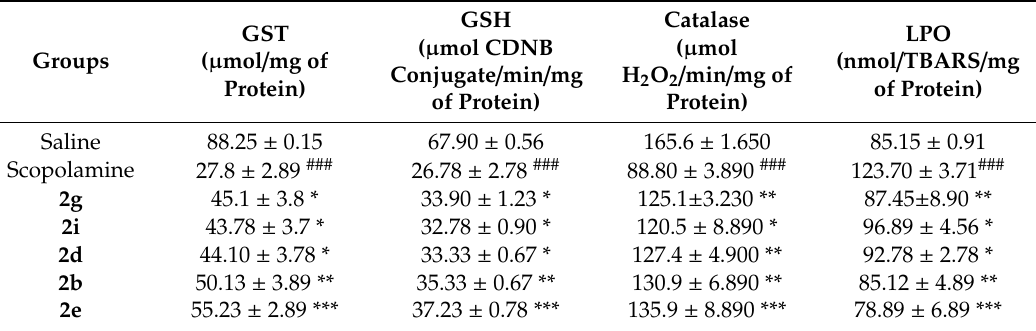
Symbols *** or ### show significant difference at p <0.001, while * and ** show significant difference at p <0.05 and p <0.01, respectively. The symbol * shows a significant difference relative to scopolamine and # shows significant difference relative to saline. Data are shown as mean± SEM